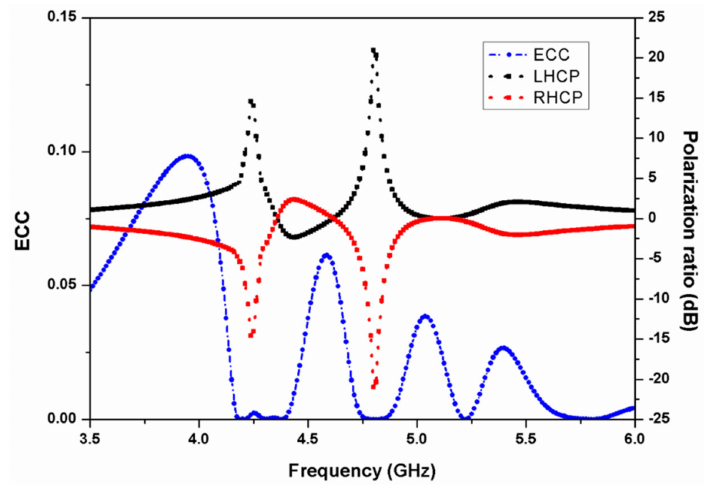
Figure 8. ECC and polarization ratio response of the two-element stacked MIMO antenna.